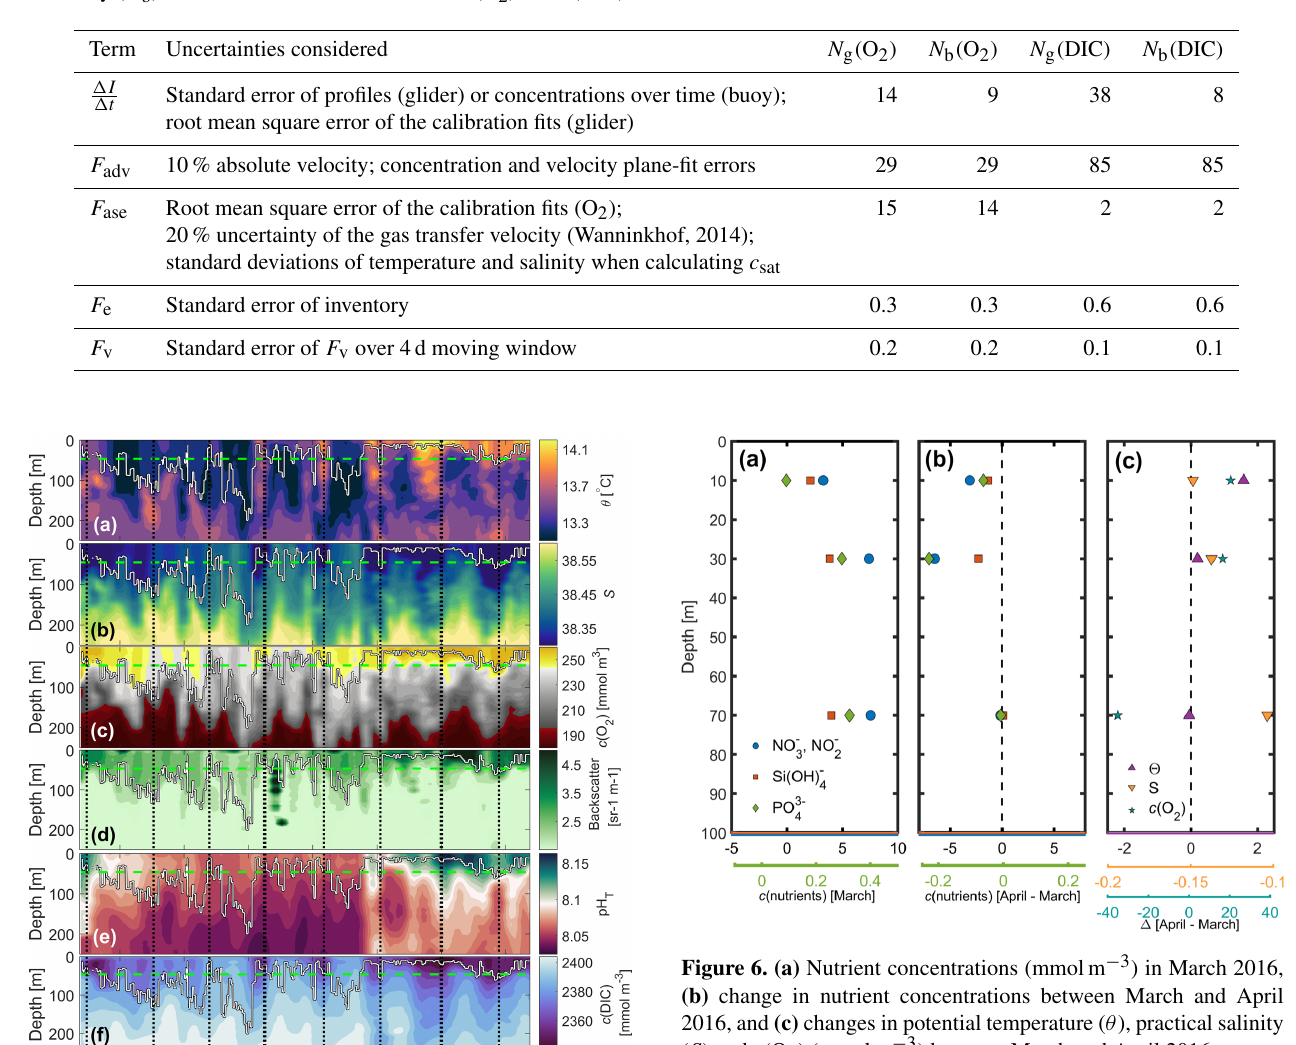
Table 1. The uncertainties considered for each flux term when estimating total propagated error. The mean errors for N using glider ( N g ) and buoy ( N b ) measurements are listed for both c( O 2 ) and c( DIC ) in mmolm − 2 d − 1 .